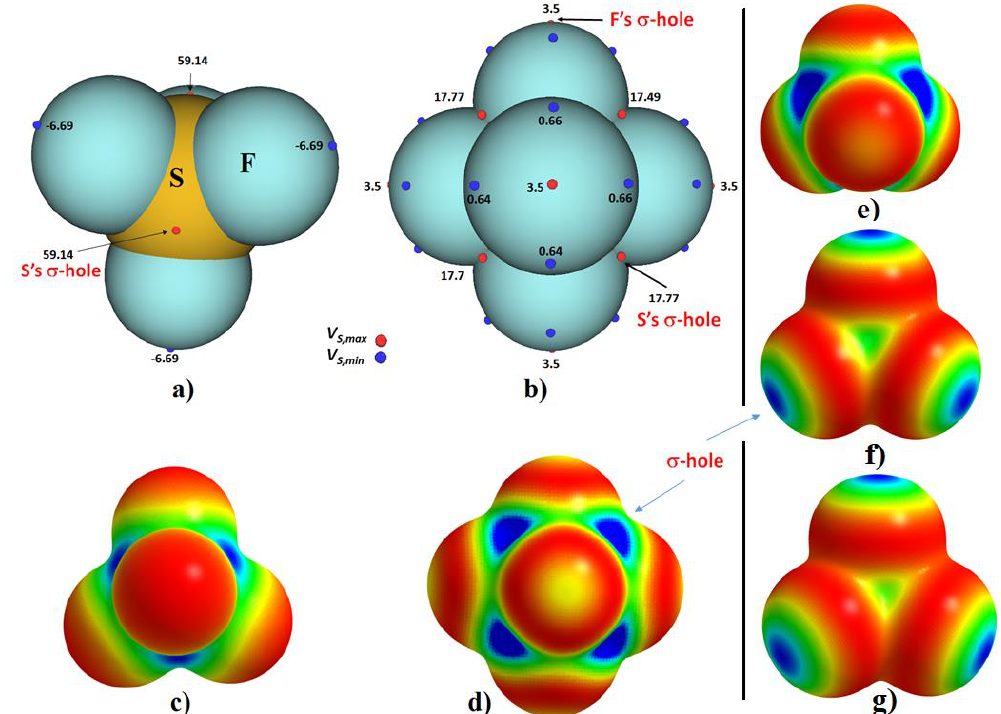
Figure 3. M06-2X/aug-cc-pVTZ level 0.0020 a.u. mapped potential on the electrostatic surface of ( a ) SF 4 and ( b ) SF 6 (this work). The atom–atom overlapping model is shown in ( a , b ), whereas the 3D model of the corresponding species is illustrated in ( c , d ), respectively. Values, which refer to extrema of electrostatic potential, are in kcal mol −1 . The S atom’s σ-hole regions marked in ( a , b ) refer to the triangular blue regions in ( c , d ), whereas the σ-hole of the F atom refers the circular yellowish region on the fluorine’s outer surface in ( d ), and is not evident of the same atom in ( c ). Included are also the 0.001 a.u. envelope mapped MESP plots for ( e ) CF 4 , ( f ) CCl 4 , and ( g ) CBr 4 (this work). Color: blue: strongly positive; red: strongly negative.